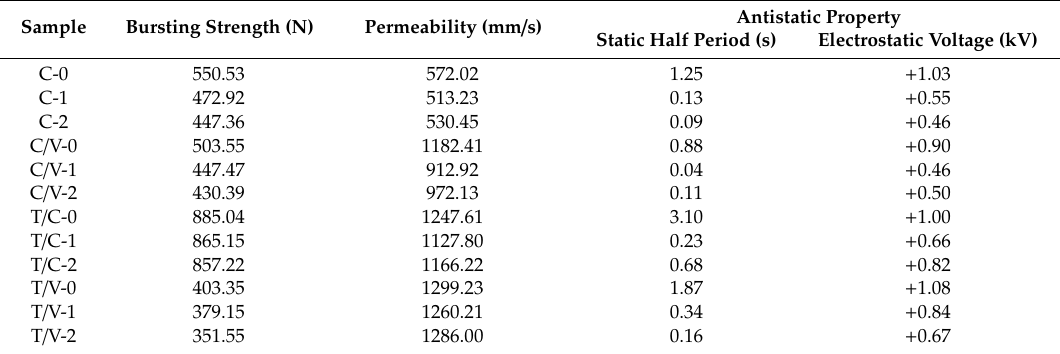
Table 3. Bursting strength, permeability and antistatic property of original and treated fabrics.